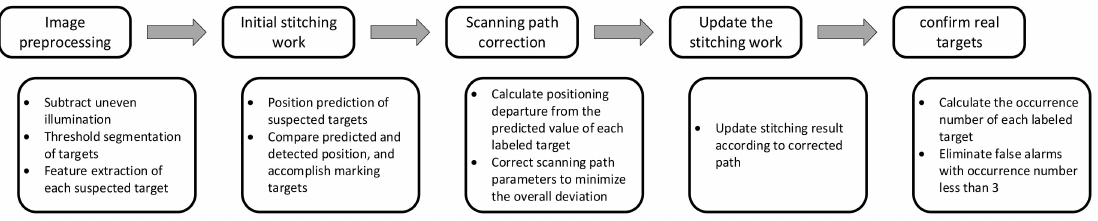
Figure 8. Diagram of the